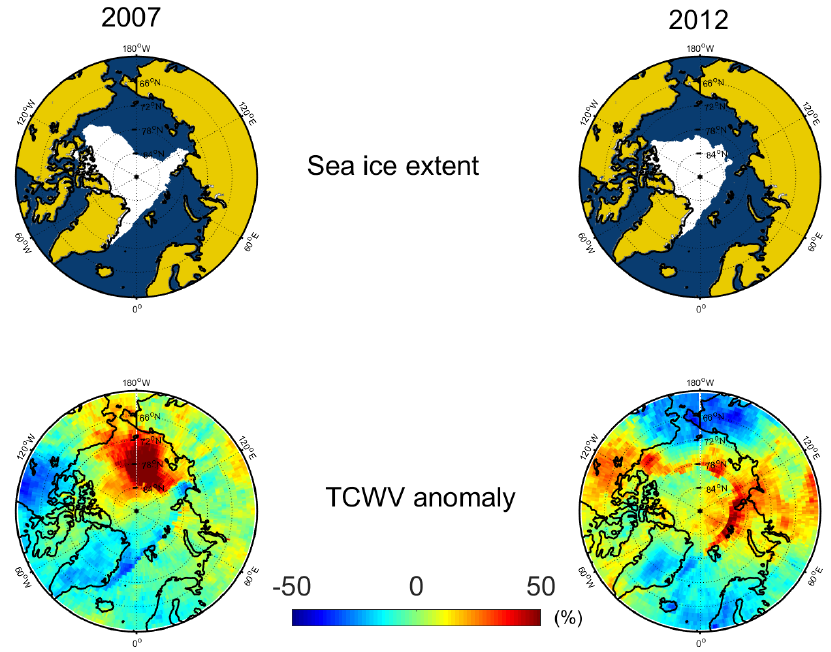
Figure 9. September sea ice extent (white areas of the upper plots) and TCWV anomaly (%, lower plots) for 2007, and 2012. Anomaly is calculated with respect to (2001–2015) mean.